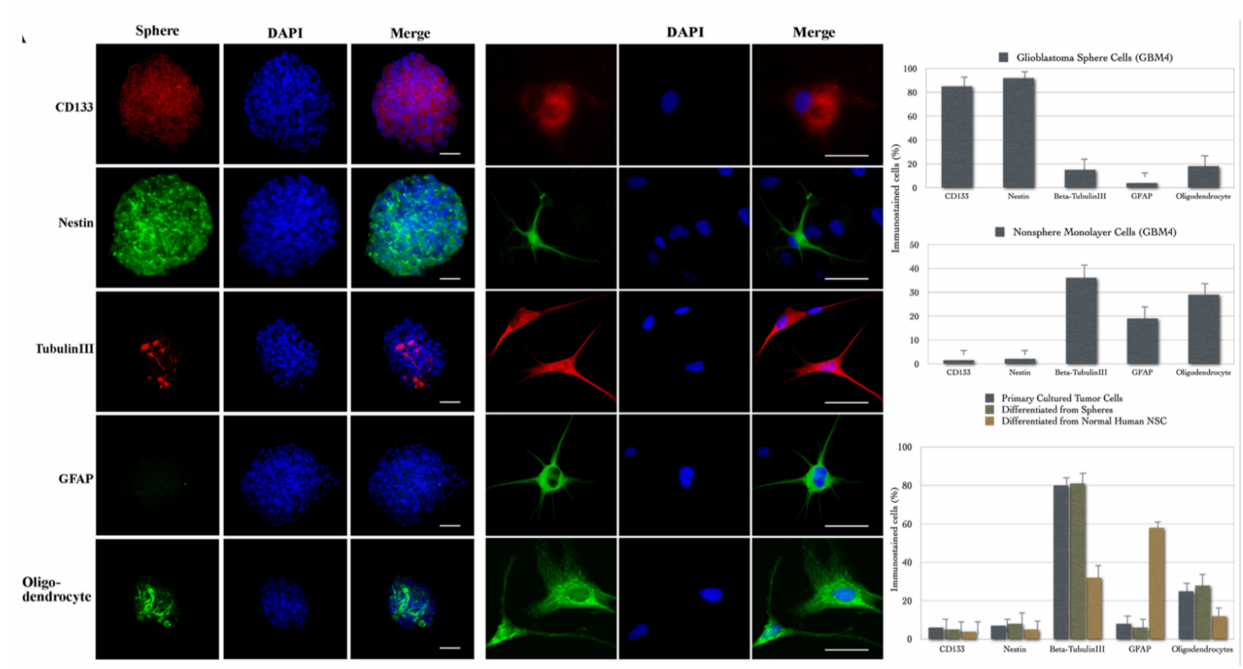
Figure 7. Glioblastoma cancer stem cells discovery and characterization by imaging. ( Left ): Single-mother-cell-derived glioblastoma spheres express NSC markers as well as lineage markers, but with different staining profiles from non-sphere tumor cells. Glioblastoma spheres derived from a single mother cell were stained by NSC markers CD133 (red) and Nestin (green). Lineage markers for neuron, b-tubulin III (red) and oligodendrocyte, myelin/oligodendrocyte (green) were stained, but staining for the astrocyte marker, GFAP, was not observed in the glioblastoma sphere. Cells were located by counterstaining with DAPI (blue); ( Middle ): Glioblastoma sphere-differentiated progenies show a phenotype similar to the parental tumor, but different from that of normal human neurospheres. Differentiated progenies of glioblastoma spheres were stained for the NSC markers, CD133 (red) and Nestin (green). The cells were also stained for lineage-specific markers of neuron (red), astrocyte (green), and oligodendrocyte (green). ( Right ): Stem-like cells derived from glioblastoma express neural stem cell lineage markers (top) and are multipotent (bottom). Scale bars = 50 µ m throughout. Modified from [55], where more details can be